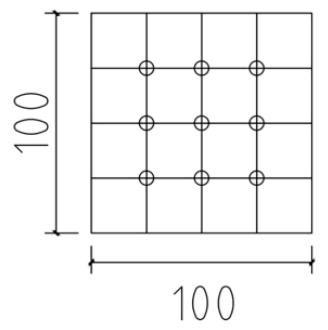
Figure 3. Distribution of nine test points.